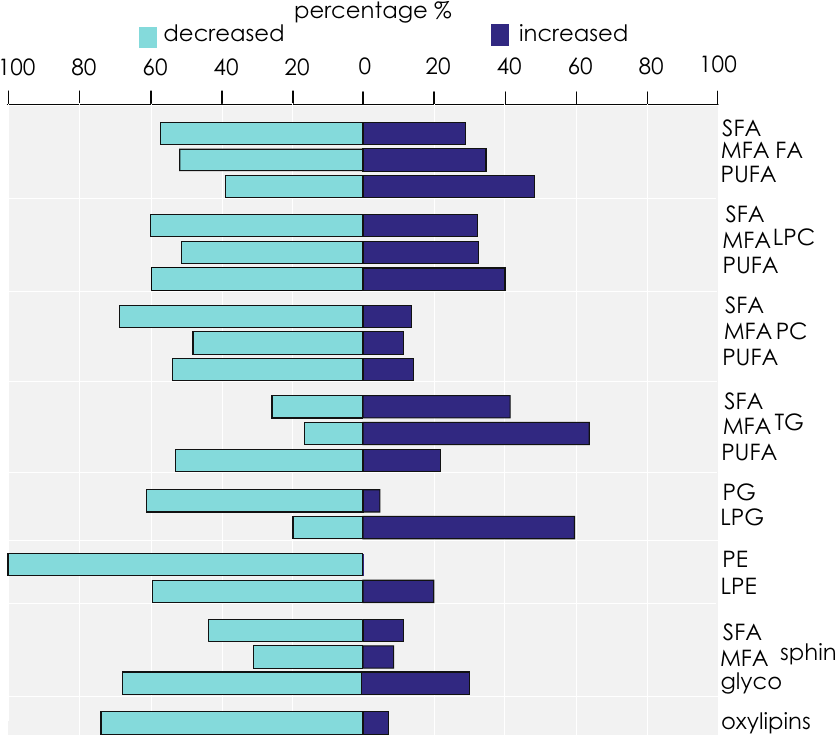
Figure 5. Signal of different lipid cateogires among the different reproductive categories. Barplot presenting the sum of SFA-, MFA-, and PUFA- lipids within each lipid category with a trend of total signal decrease or increase in female, compared to nonreproductive individuals within each lipid category. Abbreviations: free fatty acids (FFA), phosphatidylcholines (PC), lyso-phosphatidylcholines (LPC), triacylglycerides (TGs), phosphatidylglycerols (PG), lyso-phosphatidylglycerols (LPG), phosphatidylethanolamines (PE), lyso- phosphatidylethanolamines (LPE), saturated (SFA), mono-unsaturated (MFA), poly-unsaturated